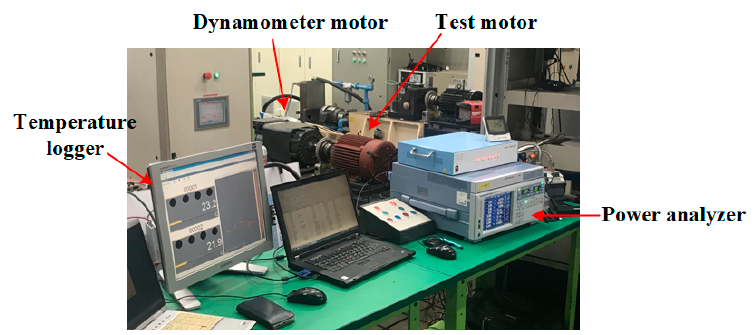
Figure 15. Experiment environment and test dynamometer.